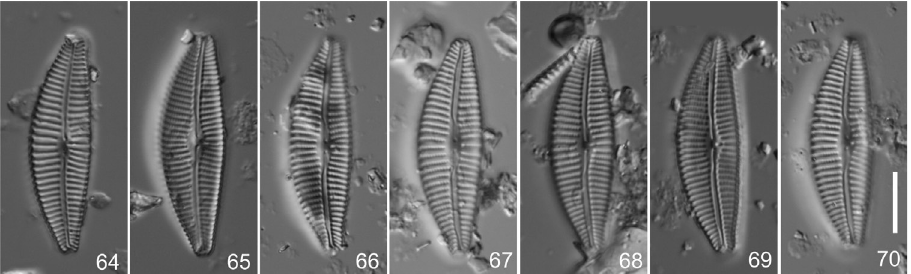
Cymbella subturgidula Krammer, Diatoms Europe 3: 166, Figs. 44: 19–21, 2002. Synonyms. = Cymbella turgidula var. nipponica Skvortzov, Philipp. J. Sci. 61: 283, Figs. 2:8, 4:4, 1936. (Figs 78–97) – Cymbella uenoi Skvortsov in Skvortsov & Noda, Sci. Rep. Niigata Univ., ser. D (Biol.) 8: 19, Pl. 3, Fig. 3, 1971. (nom. inval.) = Cymbella rheophila Ohtsuka in Ohtsuka & Tuji, Phycol. Res. 50: 245, Figs 7, 8,